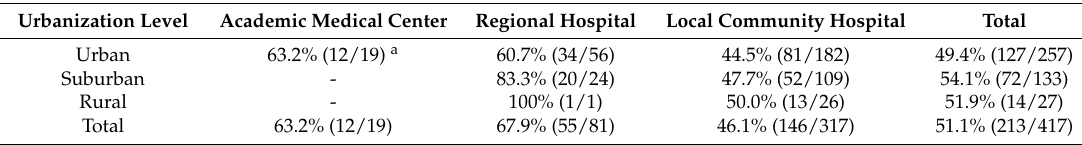
Table 1. Proportion of hospitals with official Facebook fan pages among all 417 hospitals in Taiwan, stratified by accreditation type and urbanization level.